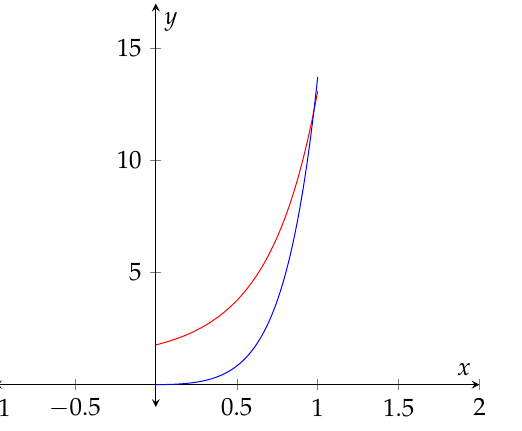
√ π e x 2 + x (red color), f 2 ( x ) = x 2 ( 1